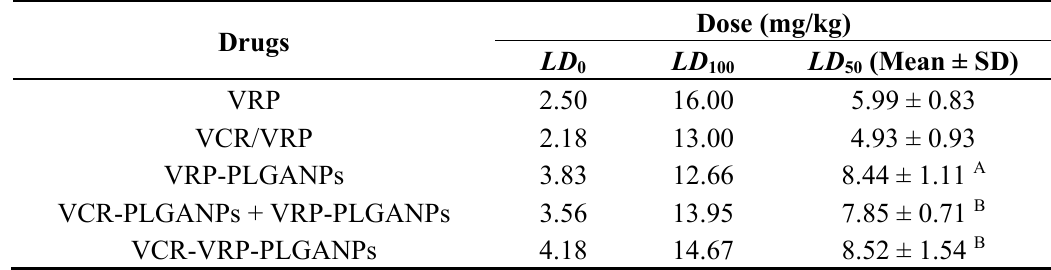
Table 4. The LD 0 , LD 50 and LD 100 values of VCR-VRP-PLGANPs in comparison with